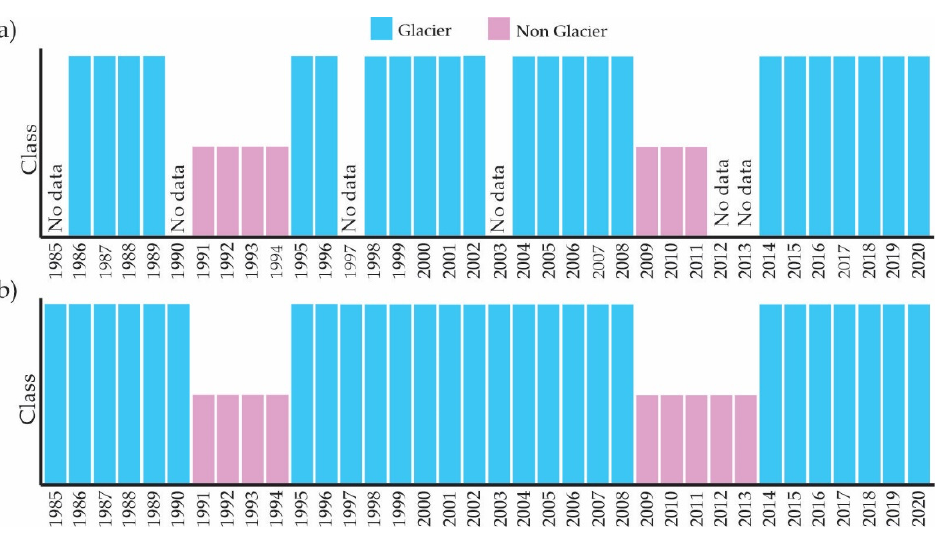
Figure 6. Effect of the gap ‐ fill filter application: ( a ) time series of the original classification (before the filter application), and ( b ) time series of the filtered classification (gap ‐ filled).